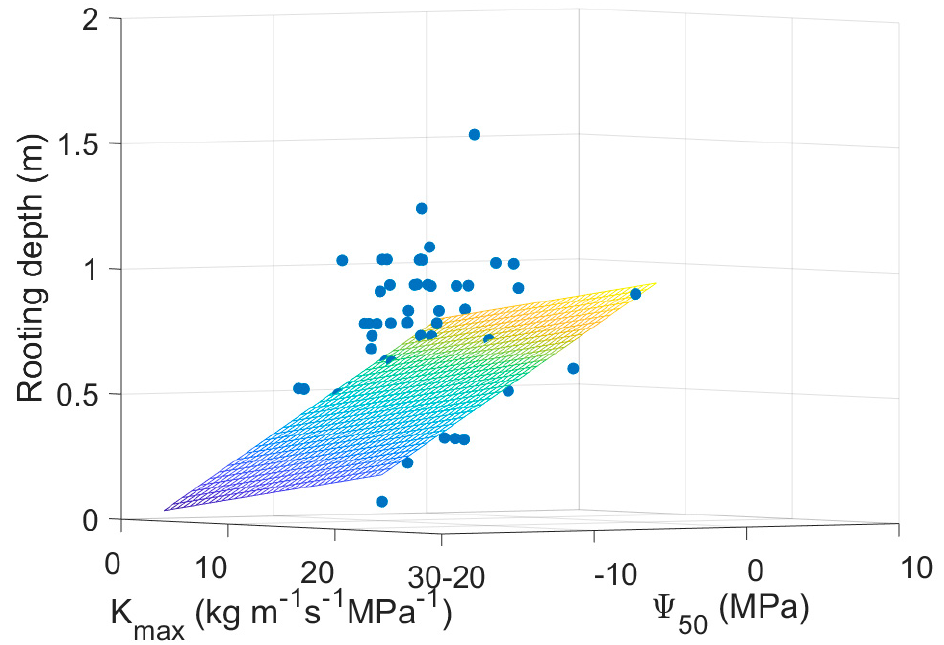
Figure 2. Multiple linear regression demonstrates a significant relationship between xylem traits (K max and Ψ 50 ) and rooting depth ( R 2 = 0.1345, p = 0.0048). Markers represent individual species ( n = 78).